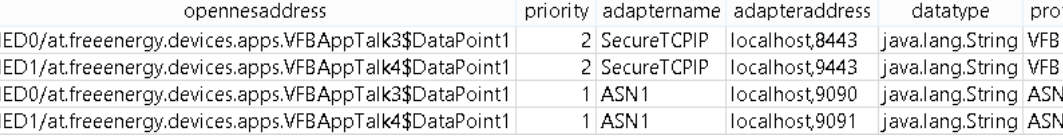
Figure 18. Address mapping on intelligent electronic device (IED)0 during Test (c).